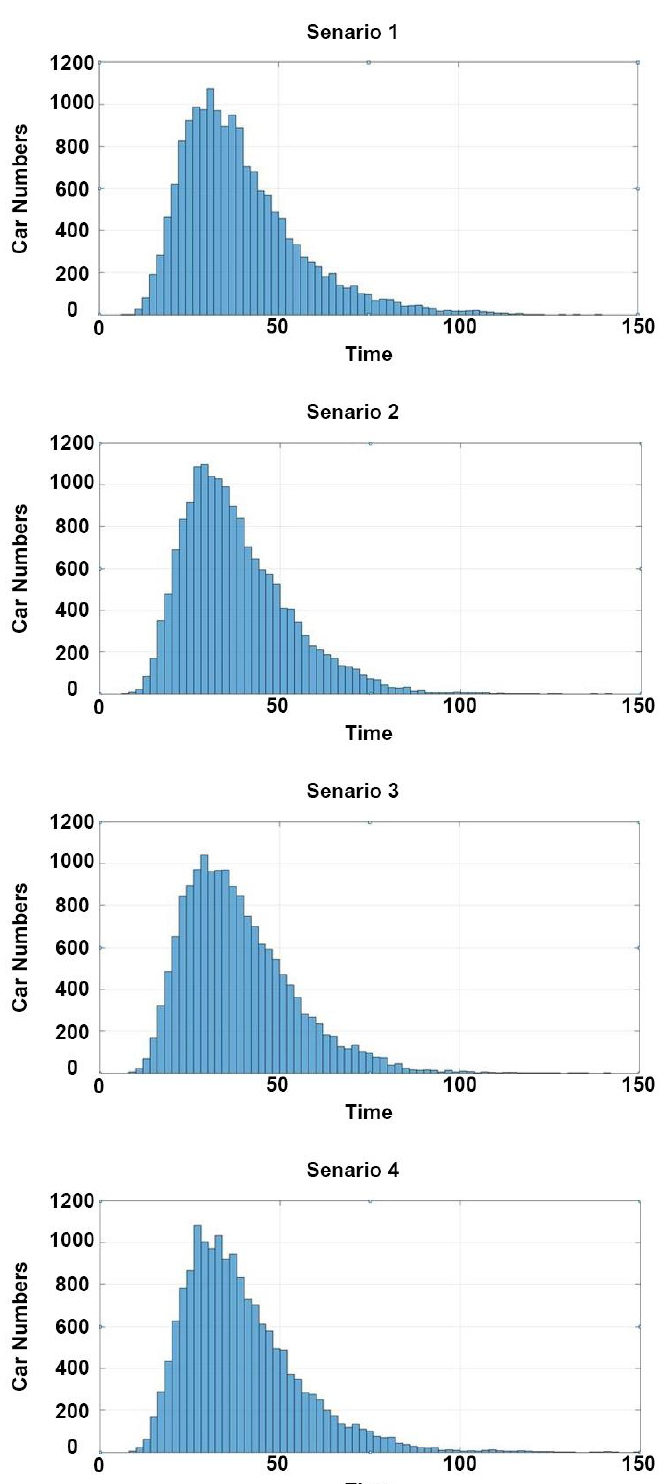
Fig. 8. The results of the simulator, the horizontal axis of travel time and the vertical axis of the number of cars for each